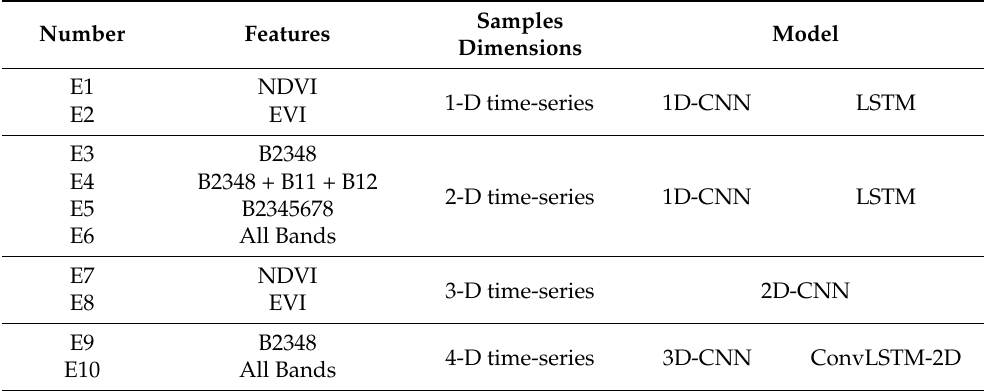
Table 4. Experiment